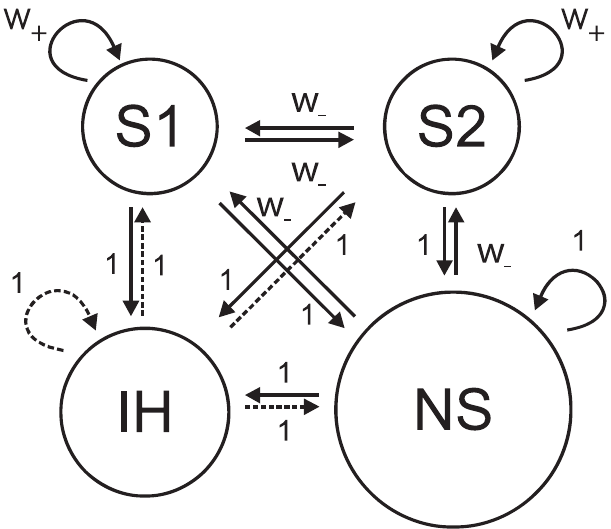
Figure 8. The Attractor Network Model